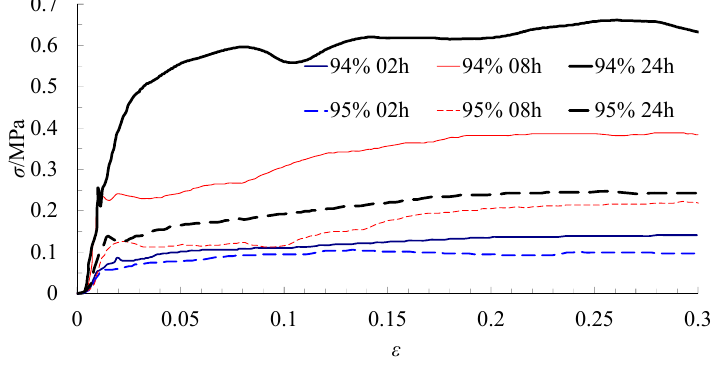
Figure 10. Stress-strain curves of specimens subjected to partly confined compression.